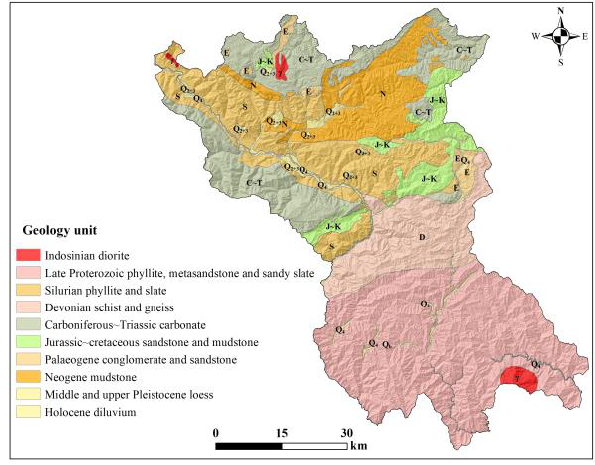
Figure 3. Geological setting of the study area. The geological map is derived from the local government.